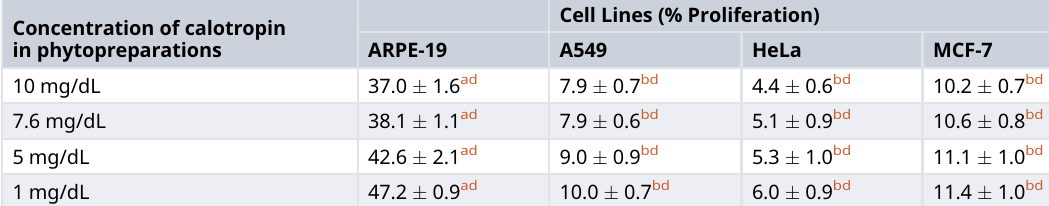
Table 1. Percentage of proliferative activity of the phytopreparations of Asclepias subulata.